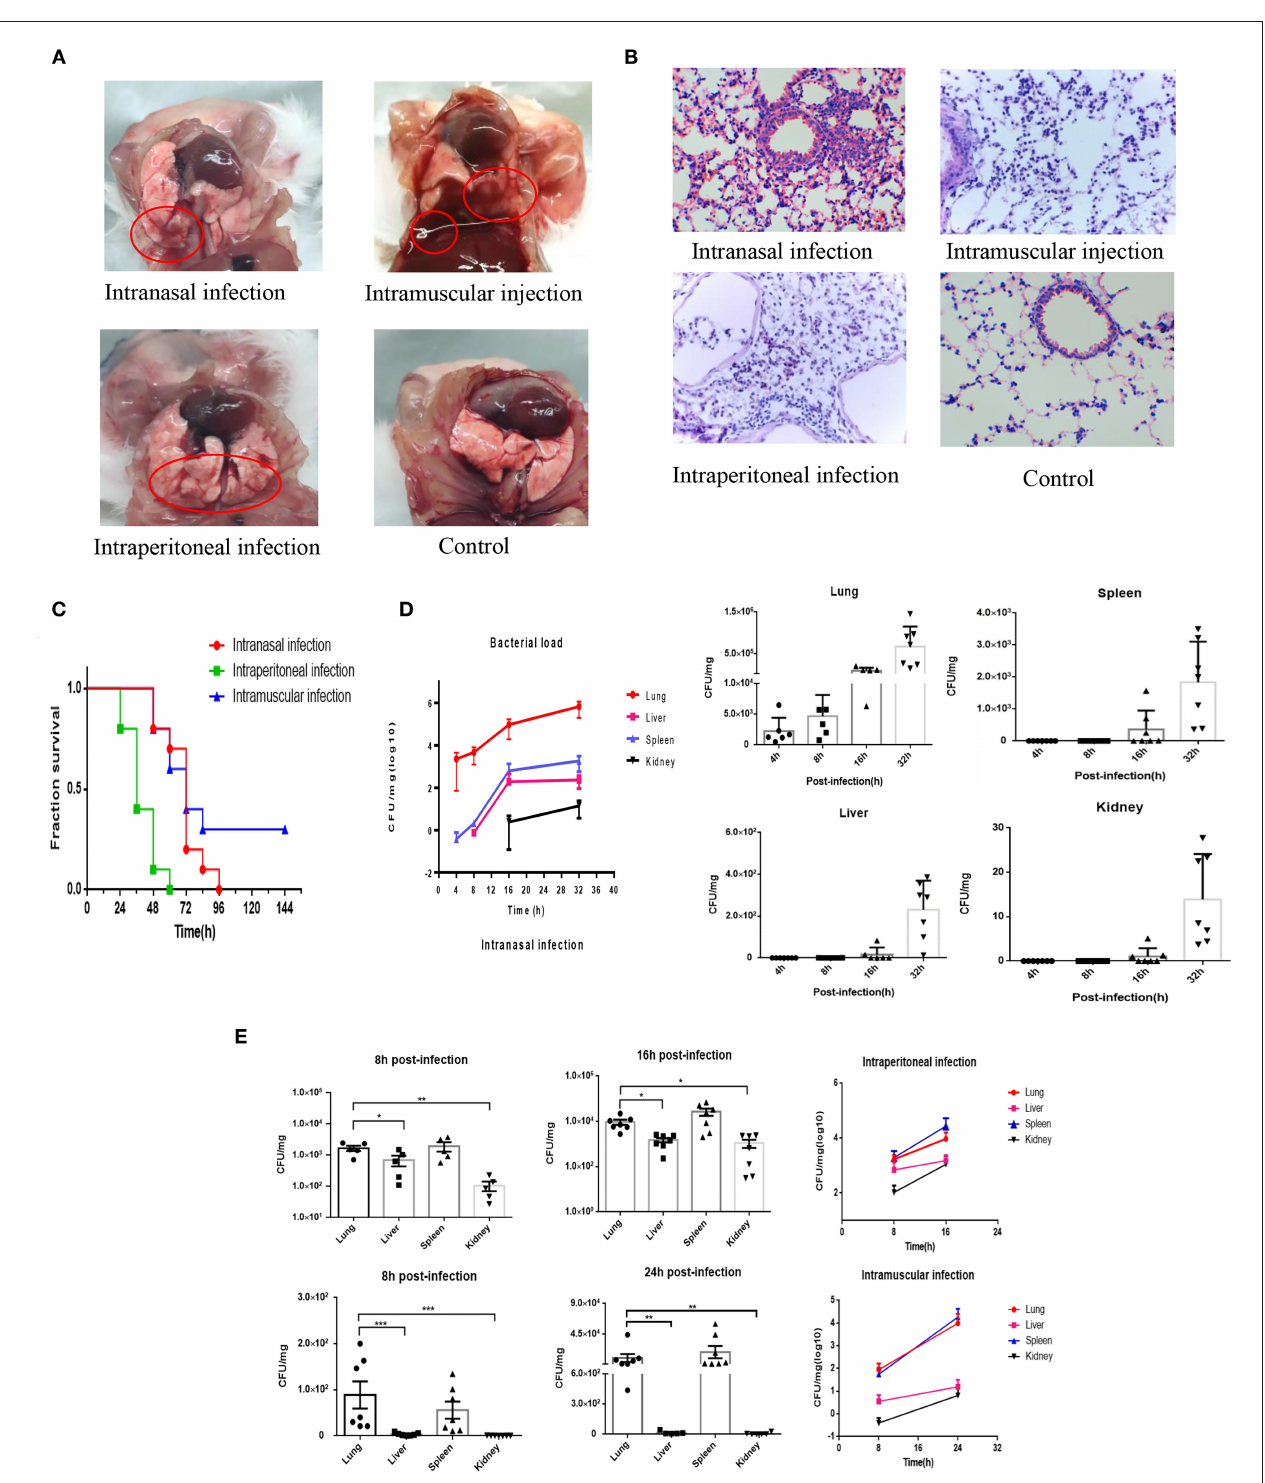
FIGURE 1 | PmCQ2 infection causes fatal pneumonia in mouse models and the infected lung has higher bacteria density than other tissue. (A,B) The lung pictures and H&E stainings ( × 400) of mice that were intranasally infected, intramuscularly infected, or intraperitionally infected with 10 4 CFU log-phase PmCQ2 for 20h, and the mice intranasally injected with saline (Control). The red circle indicates the lung damage and pulmonary effusion. (C) Survival rates of mice intranasally infected, intramuscularly infected, and intraperitionally infected with 10 4 CFU log-phase PmCQ2. (D) A time-course assay reflecting the lung, liver, spleen, and kidney bacterial density of mice intranasally infected with 10 4 CFU log-phase PmCQ2. Every single point represents one individual. (E) A time-course assay reflecting the lung, liver, spleen, and kidney bacterial density of mice intraperitoneal or intramuscular infected with 10 4 CFU log-phase PmCQ2. Every single point represents one individual. *, **, and *** represent P < 0.05, P < 0.01, and P < 0.001, respectively.